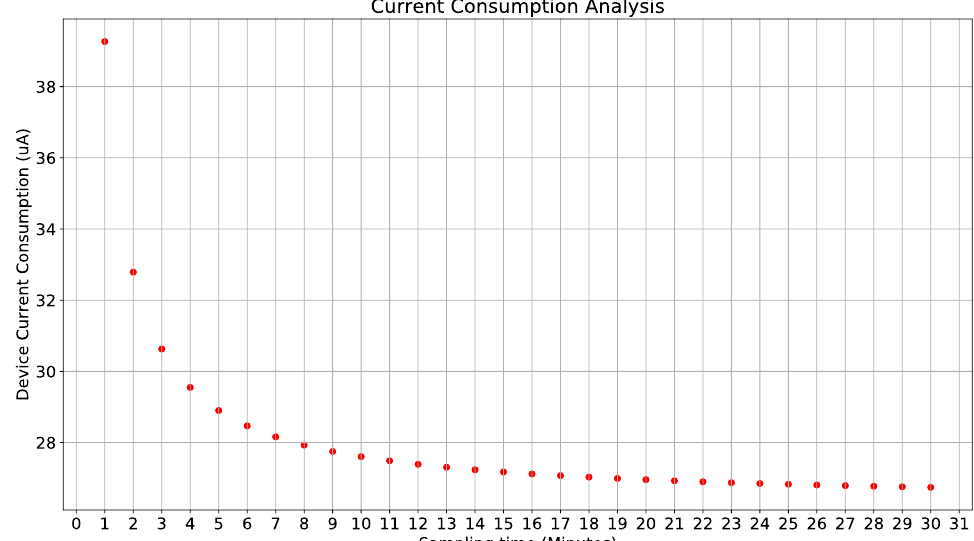
Figure 5. Current consumption vs. sampling interval.